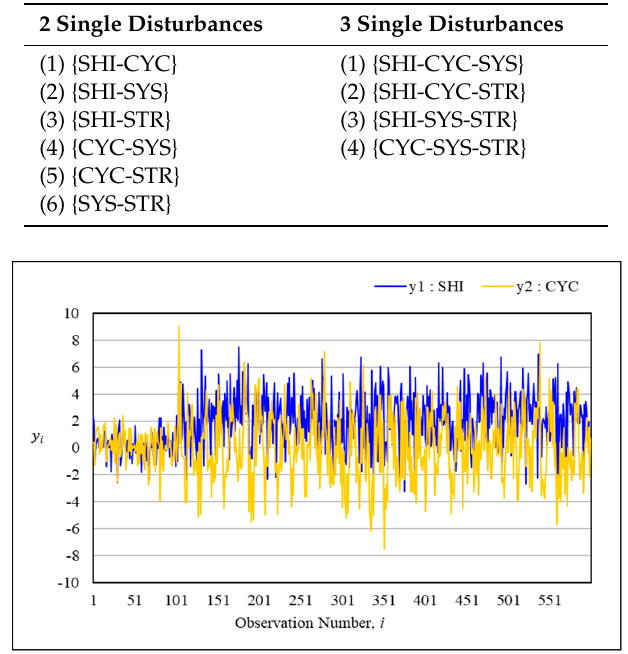
Figure 1. Two multiple-input multiple-output (MIMO) process outputs, which concurrently contain single SHI and CYC disturbances after time 100.